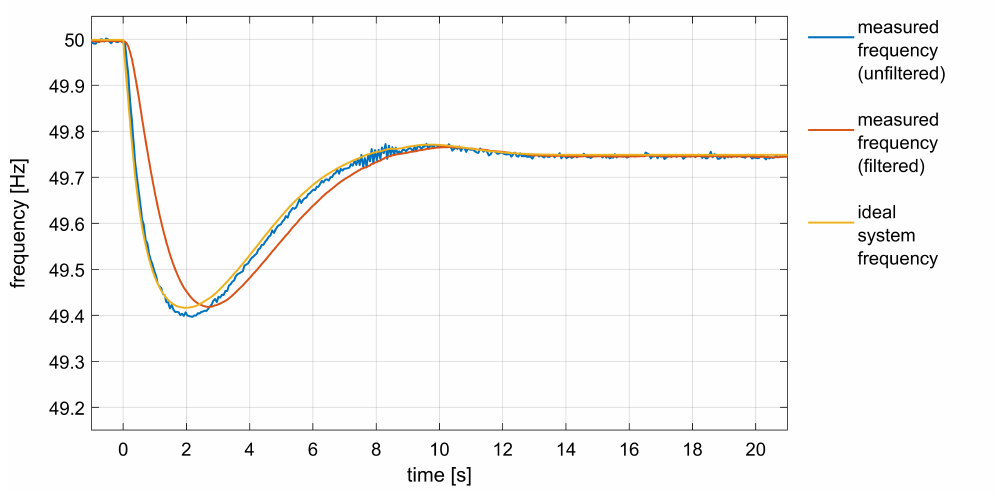
Figure 12. Frequency measured by the controller vs. ideal simulated